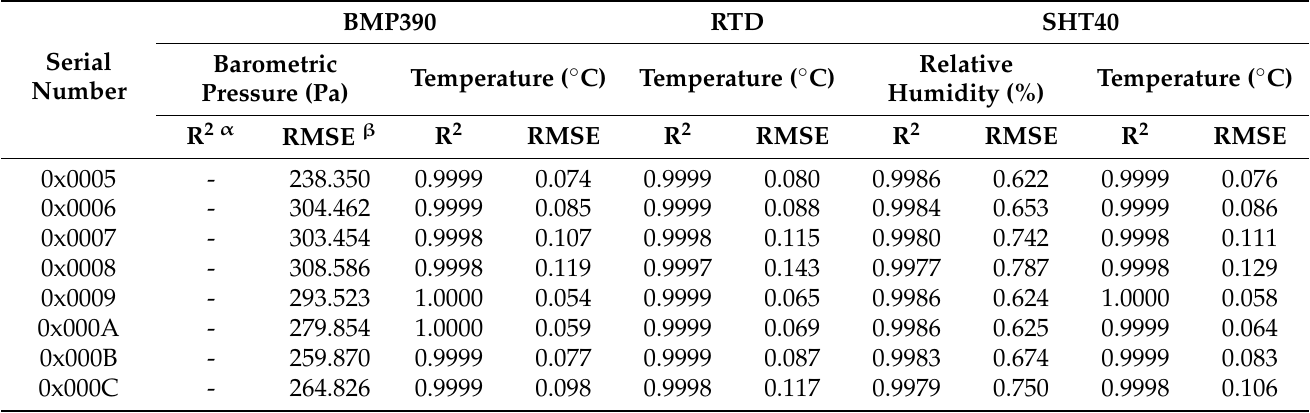
Table 8. Goodness of fit statistics, coefficient of determination (R 2 ), and root mean square error (RMSE) for calibration data.